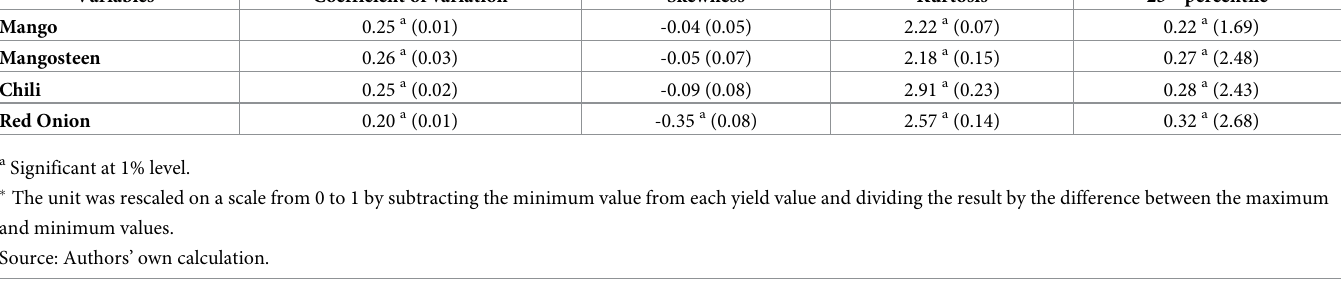
Table 4. Marginal effects from the ordinary least square’s regression of production risk on the explanatory factors (standard errors in parentheses).